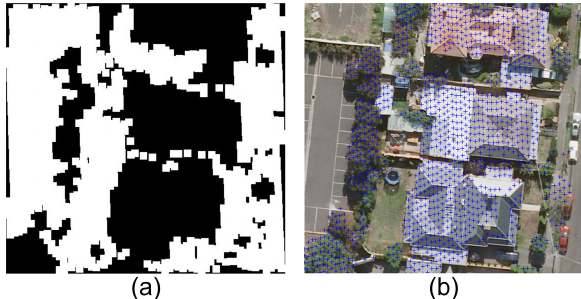
Figure 3: (a) Ground mask for the scene in Fig 2 and (b) non- ground LIDAR points are overlaid on the orthoimage.